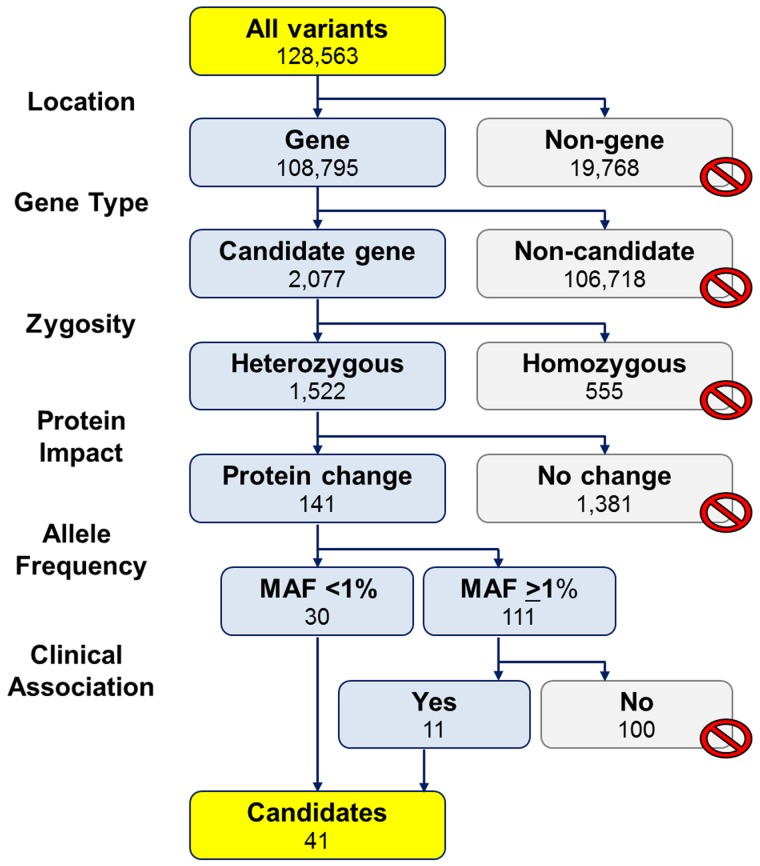
Step-wise approach to identify candidate mutations and potential modifiers.We filtered the 128,563 variants identified from exome sequencing to 41 candidates using six criteria: location (gene or non-gene), gene type (283 arrhythmia, cardiomyopathy or ion channel associated genes), zygosity, predicted protein impact, allele frequency, and clinical association. Types of variants filtered out are marked with a circle with a diagonal line. Abbreviations: MAF, minor allele frequency.